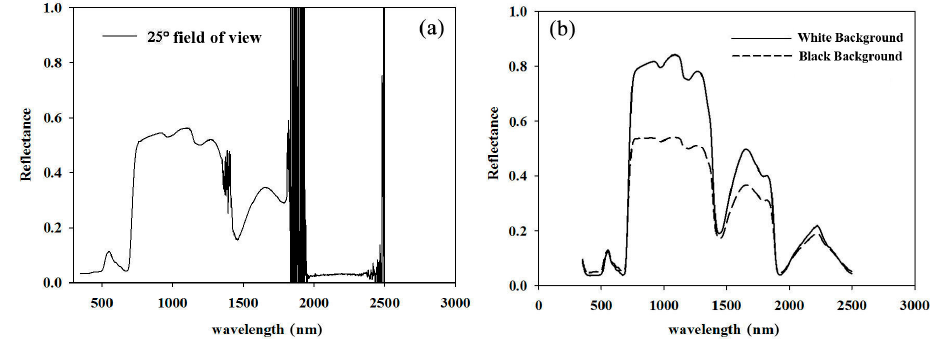
Figure 2. The characteristics of reflectance spectra of pear leaves by in-field spectral measurements using the 25° field of view ( a ); and either black background or white background ( b ) using the leaf clip.